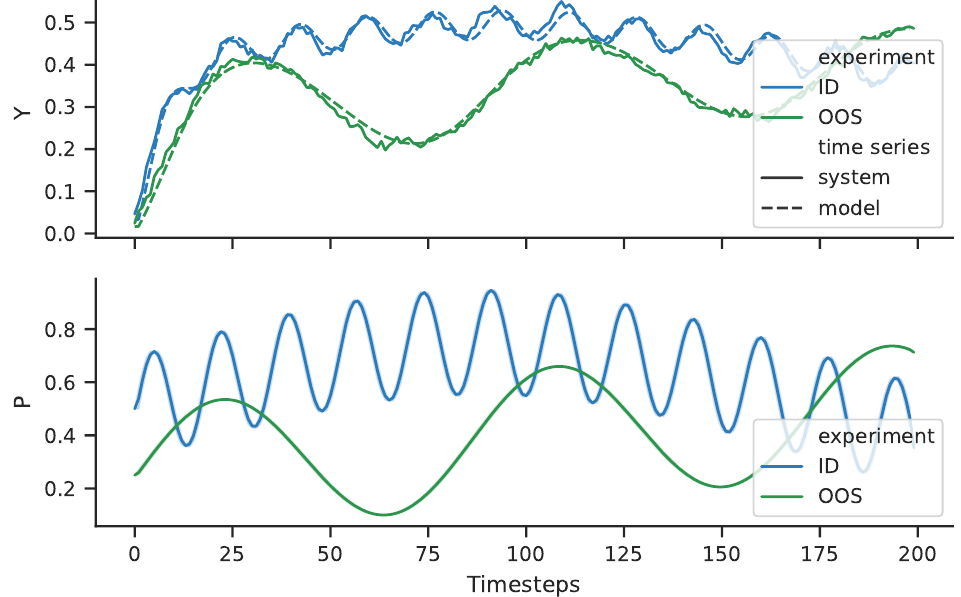
Figure 2. System response and fitted model response ( Y –space) excited by the excitation signal P . Identification experiment ID and out-of-sample experiment OOS .